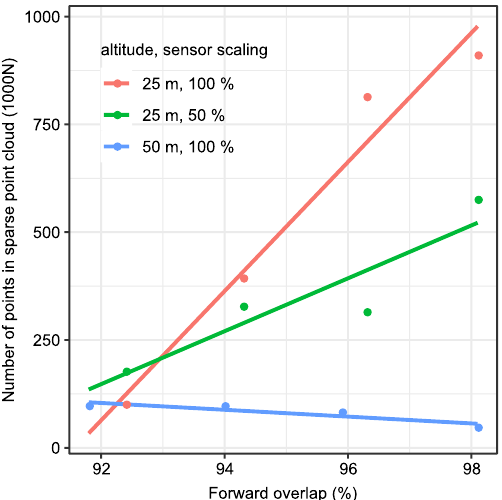
Figure 9. The number of tie points plotted over the forward overlap. Linear regression lines were inserted to show the general reaction pattern. The different colours denote different altitudes (red and green for 25m, blue for 50m). The green line denotes for a rescaled flight at 25m (GSD = 2.4cm/px) with nearly the same ground resolution as the 50m flight (2.2cm/px). Equation and regression coefficients are in Supplementary Table